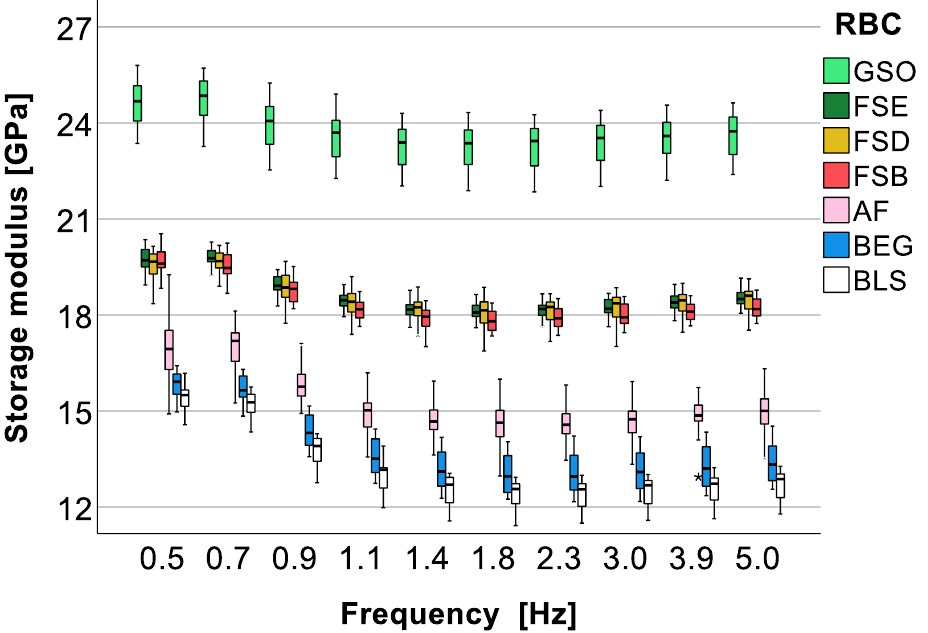
Figure 11. Dynamic mechanical analysis: storage modulus as a function of material and frequency. Material abbreviation: AF = Admira Fusion; BEG = Brilliant EverGlow; BLS = Beautifil II LS; FSB = Filtek Supreme XTE Body; FSD = Filtek Supreme XTE Dentin; FSE = Filtek Supreme XTE Enamel; GSO = Grandio SO (asterisks indicate